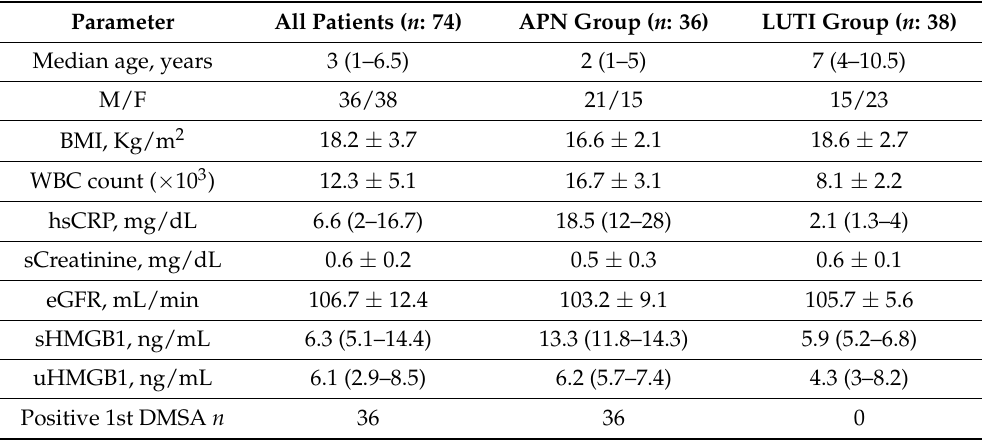
Table 1. Clinical and Biochemical Parameters of Patients with Acute Pyelonephritis and Lower Urinary Tract Infection at